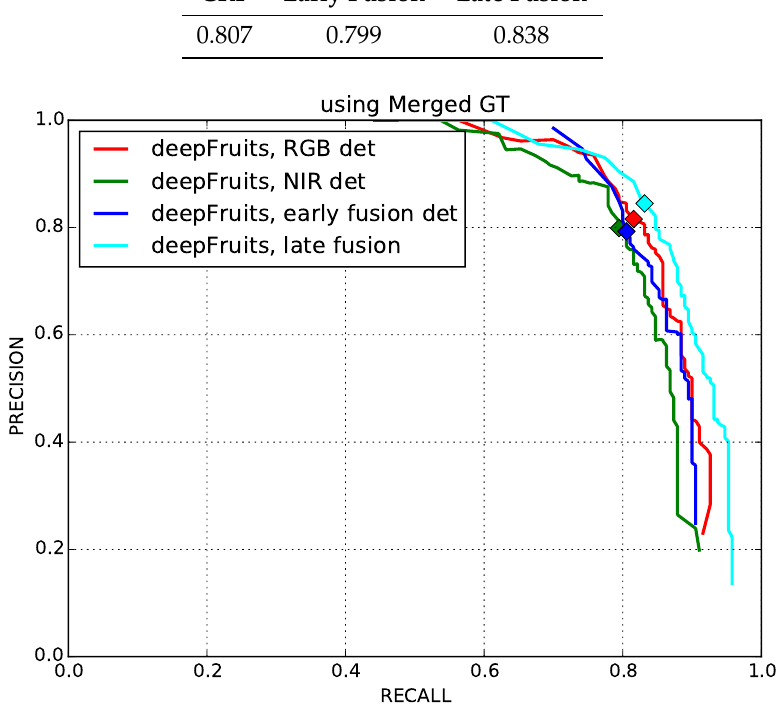
Figure 8. Precision-recall curves of four networks. The marks indicate the point where precision and recall are identical, and F1 scores are computed at these